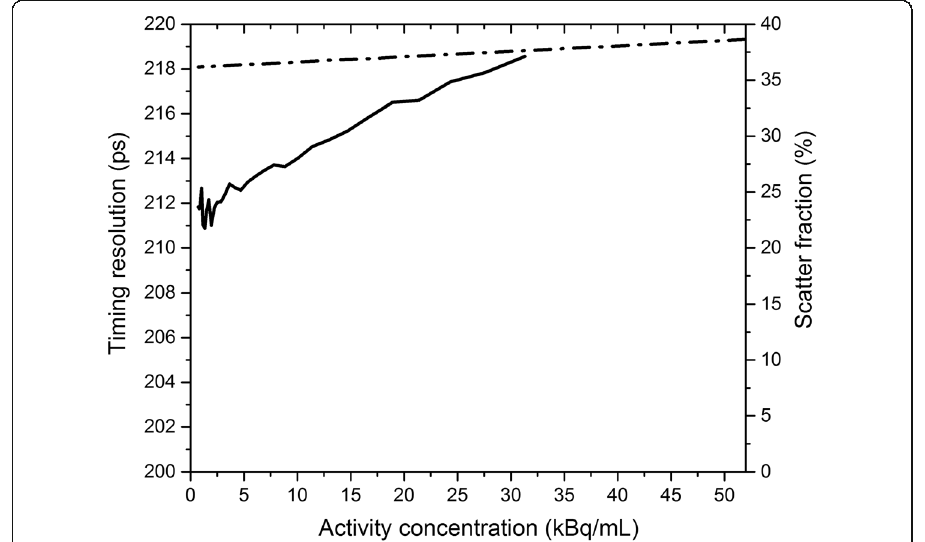
Fig. 2 Scatter fraction (dashed-dotted line) and time resolution (solid line) for the activity range